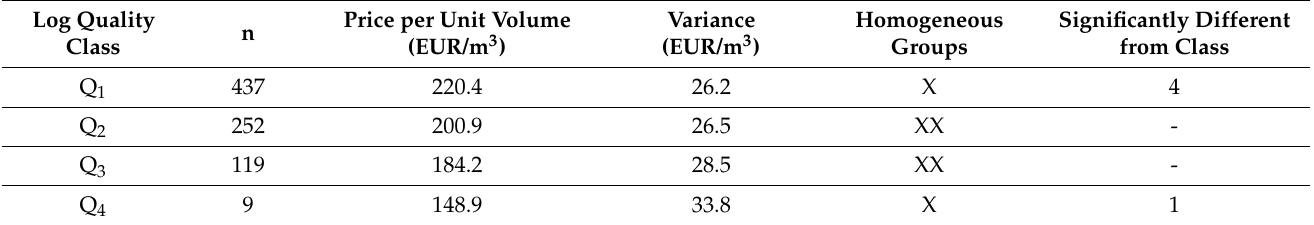
Table 5. Dependence of the price per cubic metre and the quality class of the spruce